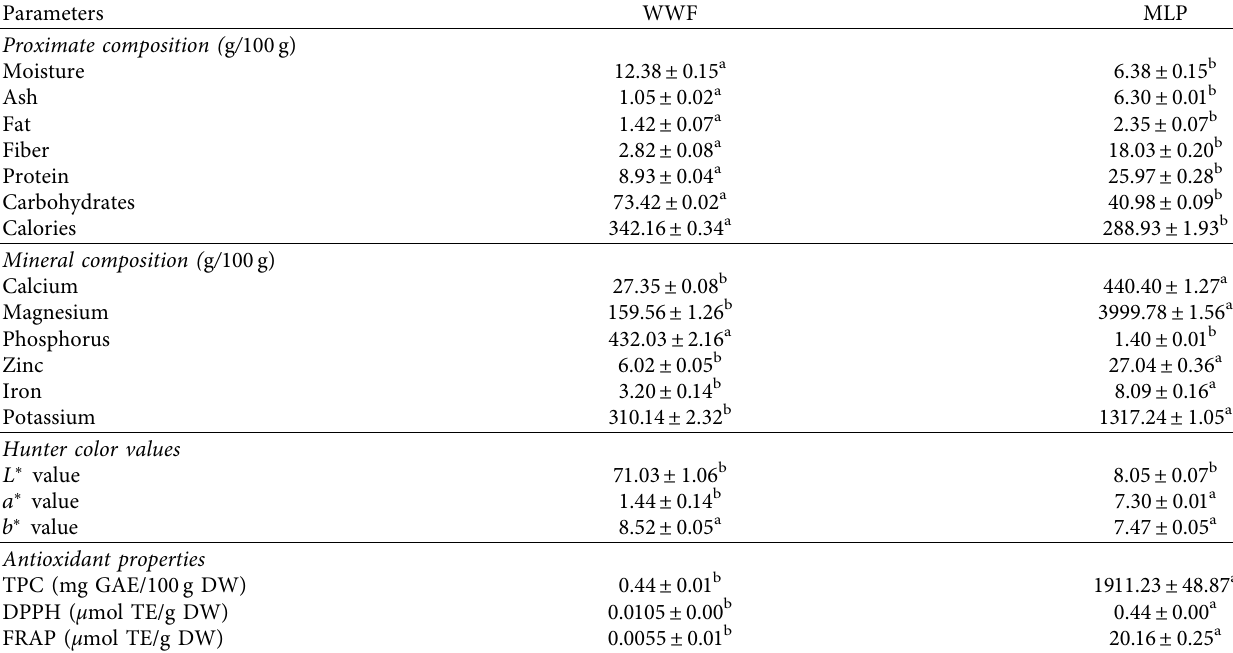
Table 2: Proximate composition, mineral composition, hunter color values, antioxidant properties of whole wheat four (WWF), and moringa leaf powder (MLP)